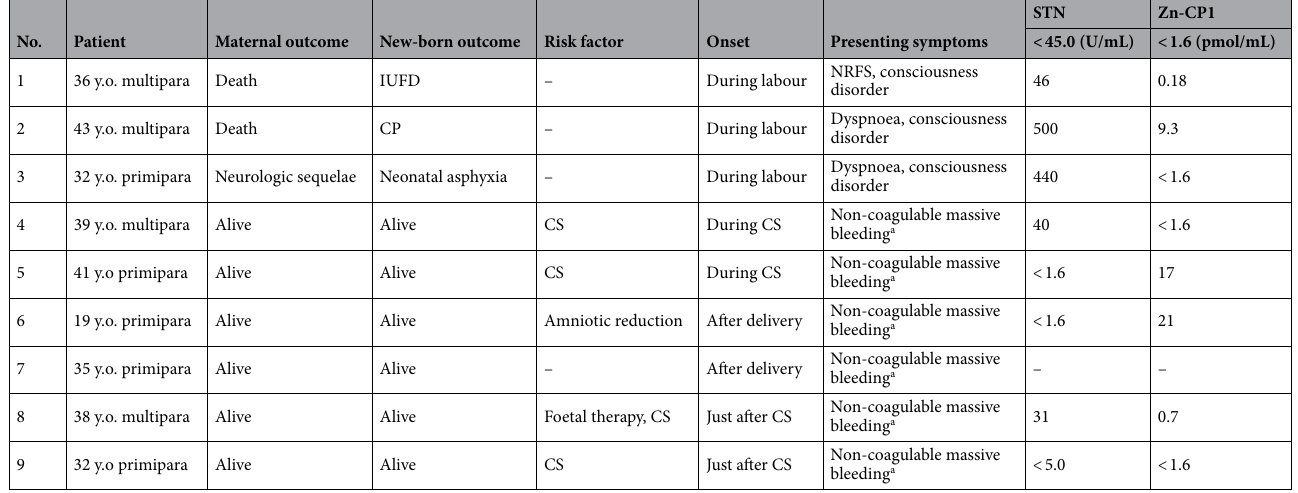
Table 1. Clinical characteristics of the patients with AFE. AFE amniotic fluid embolism, IUFD intrauterine foetal death, CP cerebral palsy, CS caesarean section, NRFS non-reassuring foetal status, STN sialyl Tn, Zn-CP1 zinc coproporphyrin. a See text for details.